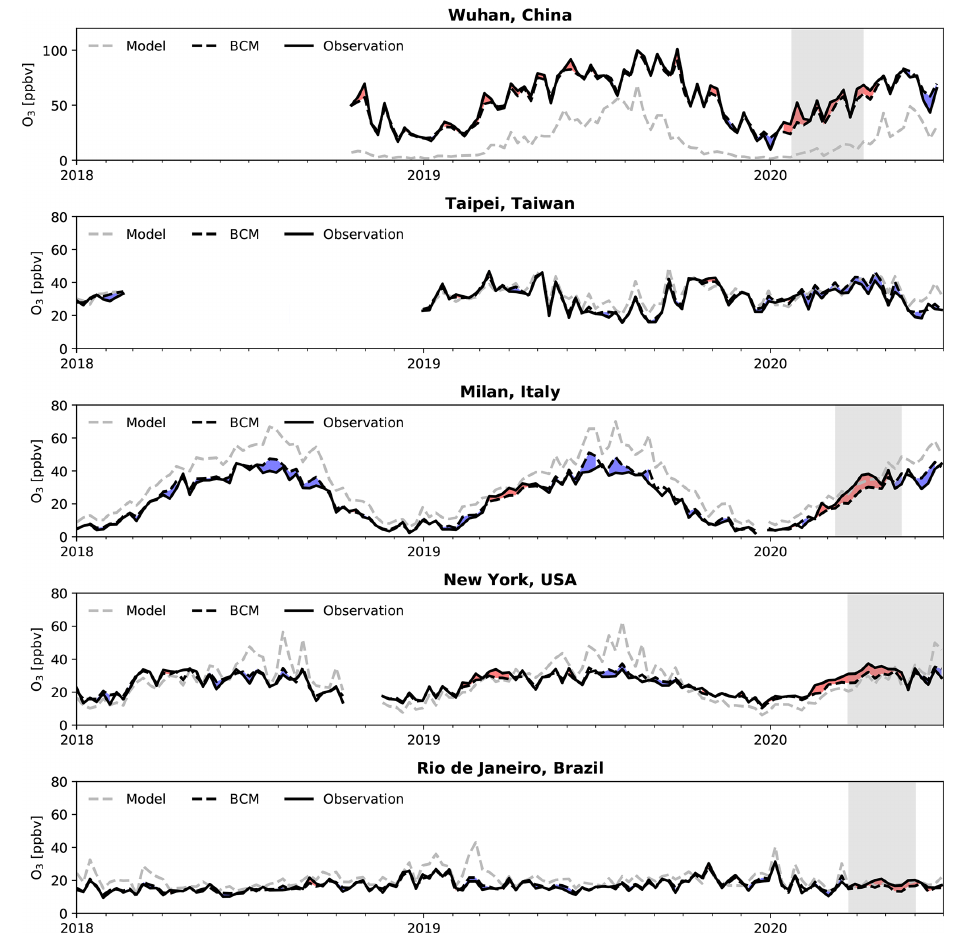
Figure 6. Comparison of O 3 surface concentrations for Wuhan, Taipei, Milan, New York, and Rio de Janeiro for January 2018 through June 2020. Observed values are shown in solid black, the original GEOS-CF model simulation is shown in dashed grey, and the BCM predictions are in dashed black. The area between observations and BCM predictions is shaded blue (red) if observations are lower (higher) than BCM predictions. The grey areas represent the period of lockdown. Shown are the 7d average mean values for the 9, 18, 19, 14, and 4 observational sites in Wuhan, Taipei, Milan, New York, and Rio de Janeiro, respectively. Observations for China are only available starting in mid-September